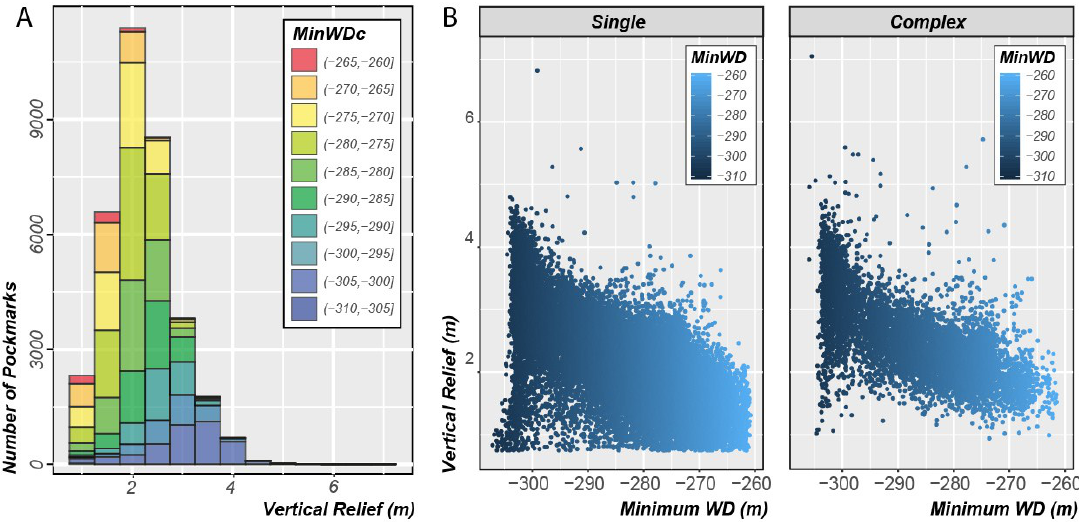
Figure 21. ( A ) Stacked histogram of the Vertical Relief values for all mapped pockmarks in the Barents Sea by minimum water depths classes; ( B ) Internal Vertical Relief versus Minimum Water Depth plot of both single and complex pockmarks.